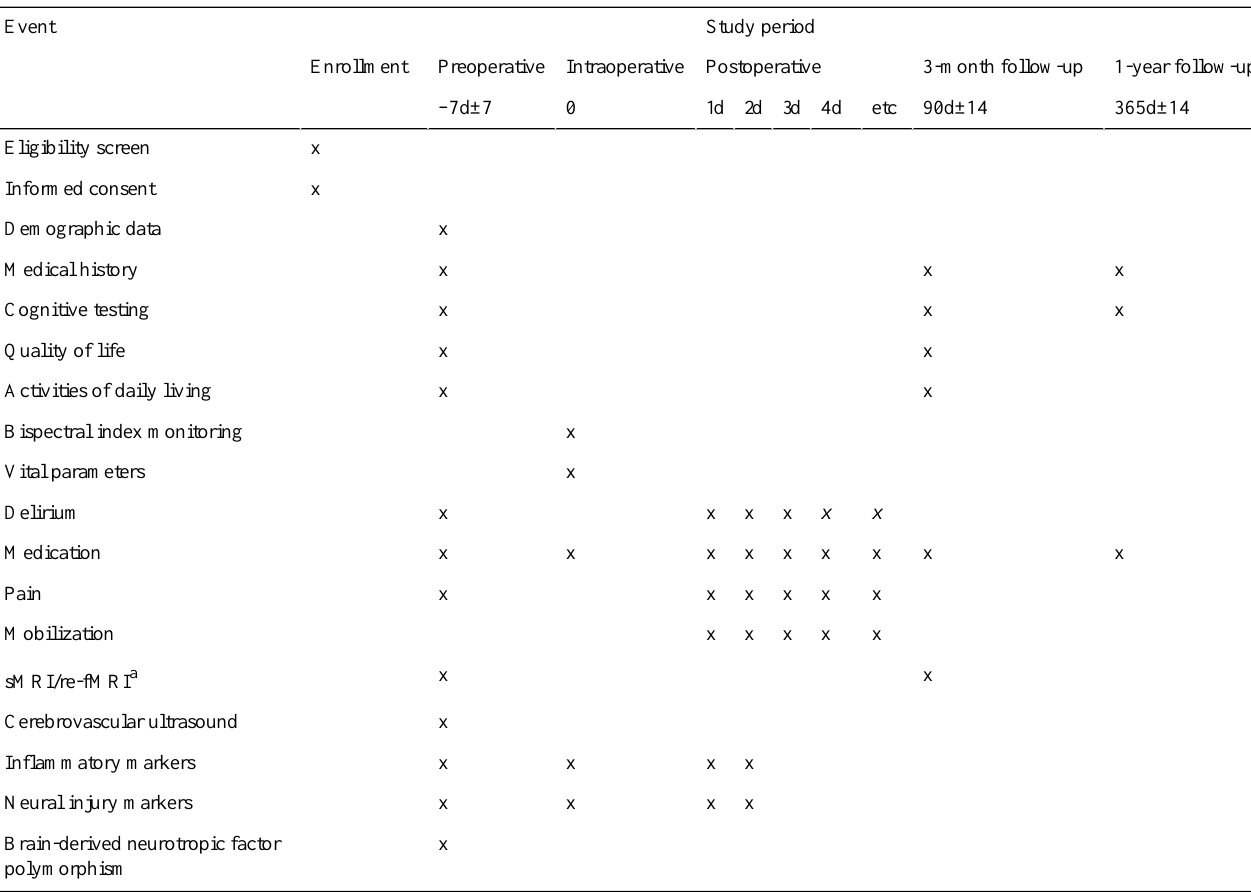
Table 1. Summary of the recruitment process and visit plan according to the Standard Protocol Items: Recommendations for Interventional Trials